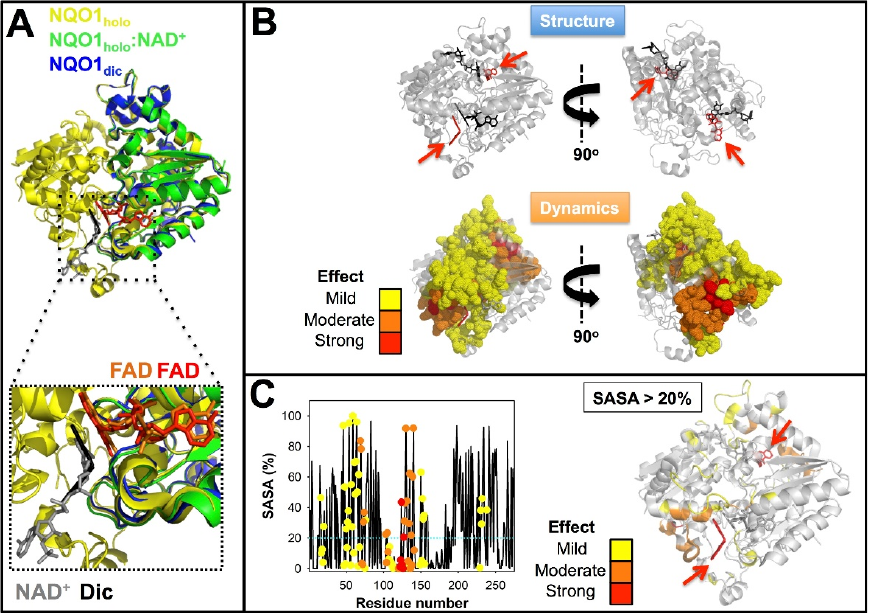
Figure 6. Structure and dynamics of NQO1 upon binding different ligands. ( A ) Structural overlay of the X-ray structures of NQO1 holo (1D4A) [81], NQO1 holo :NAD + (kindly supplied by Profs. Mario Bianchet and Mario Amzel, John Hopkins University Medical School, Baltimore, Maryland, USA) and NQO1 dic (2F1O). The lower panel shows a zoom highlighting the position of the FAD (orange, NQO1 dic and red, NQO1 holo :NAD + ), NAD + (in grey) and dicoumarol (Dic, in black). ( B ) Dicoumarol binding causes long-range effects on the structural dynamics of NQO1 WT. Residues shown in dot representation are those for which the structural dynamics is reduced according to HDXMS [132]. ( C ) Most of the residues whose dynamics are reduced upon dicoumarol binding are solvent-exposed. The plot in the left shows the solvent accessible surface area (SASA) for the each residue as calculated in [132] and color circles indicate the magnitude of the change in structural dynamics. The figure on the right shows the structural location of solvent-exposed residues (SASA > 20%). The color scales in panels B and C reflect the magnitude of the changes in protein dynamics according to [132] and red arrows indicate the position of